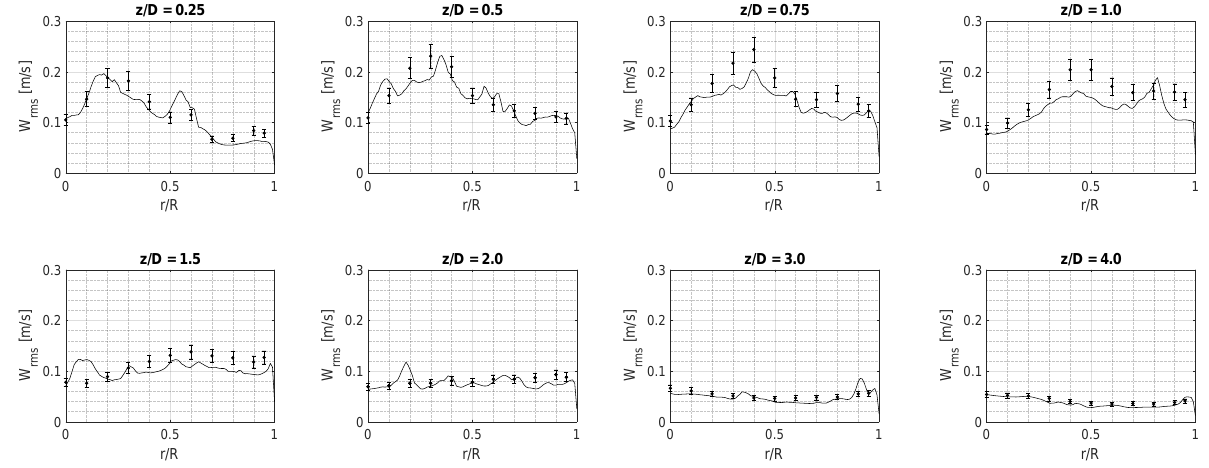
Figure 11: RMS of axial velocity at several cross sections (solid line: WALE LES, dots: experiments)